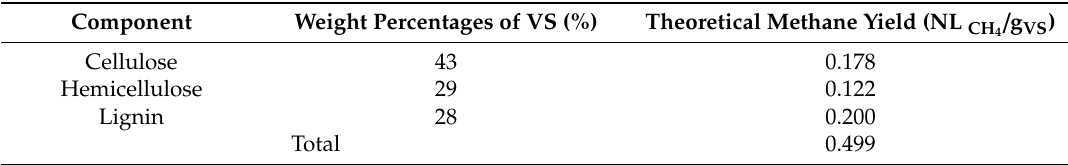
Table A3. Calculation of theoretical methane productivity of SB.